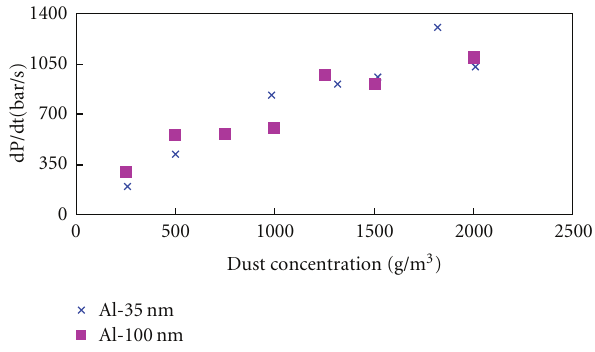
Figure 4: (dP/dt) max test results for 35 nm Al ( × ) and 100nm Al ) powders. ( (cid:0)